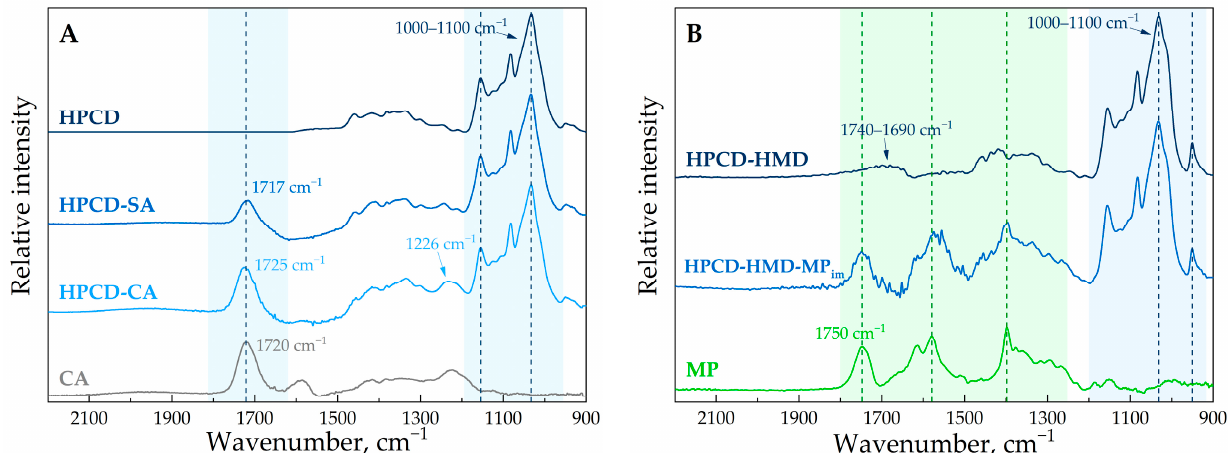
Figure 2. Normalized FTIR spectra of ( A ) HPCD, HPCD-Succinic acid polymer, HPCD-Citric acid polymer, and citric acid; ( B ) HPCD-HMD, HPCD-HMD-MP im , and MP in the range of 2200–900 cm − 1 , H 2 O, 22 °C.